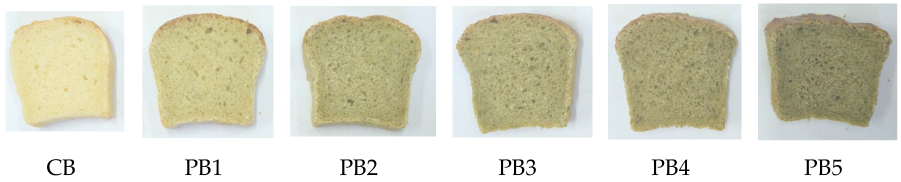
Figure 3. Control bread (CB) and bread with 1, 2, 3, 4, and 5 % of parsley leaves (PB1, PB2, PB3, PB4, and PB5, respectively). Table 2. Color coordinates and total color difference (TCD) of the